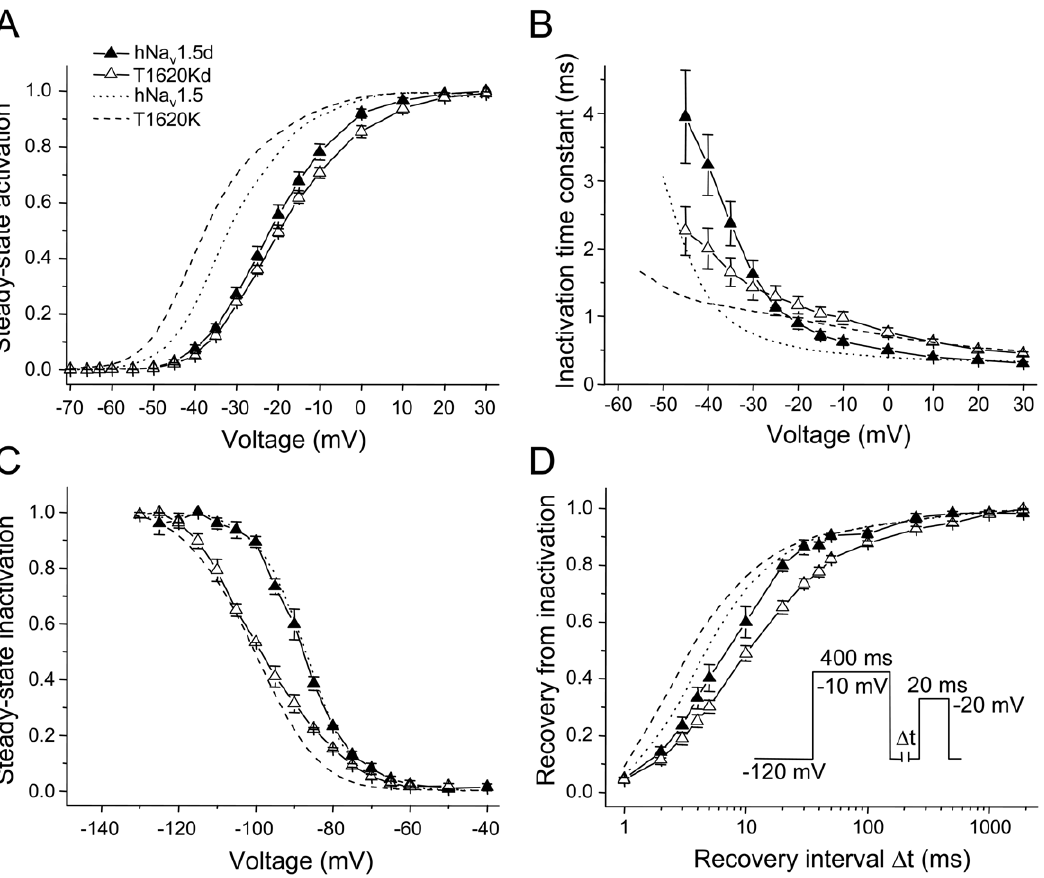
Figure 4. Electrophysiological properties of spliced hNa v 1.5d and T1620Kd channels. Steady-state activation (A), time constants of inactivation (B), steady-state inactivation (C) and recovery from inactivation (D). In hNa v 1.5d, the mid-activation potential was shifted towards depolarized potentials, and it remained unchanged in T1620Kd (A). Recovery from inactivation was slower in hNa v 1.5d compared to hNa v 1.5; it was further decelerated in T1620Kd (D). Note that the current densities were significantly reduced (Table 3), an effect that was largely due to a reduction in open probability in hNa v 1.5d [34].